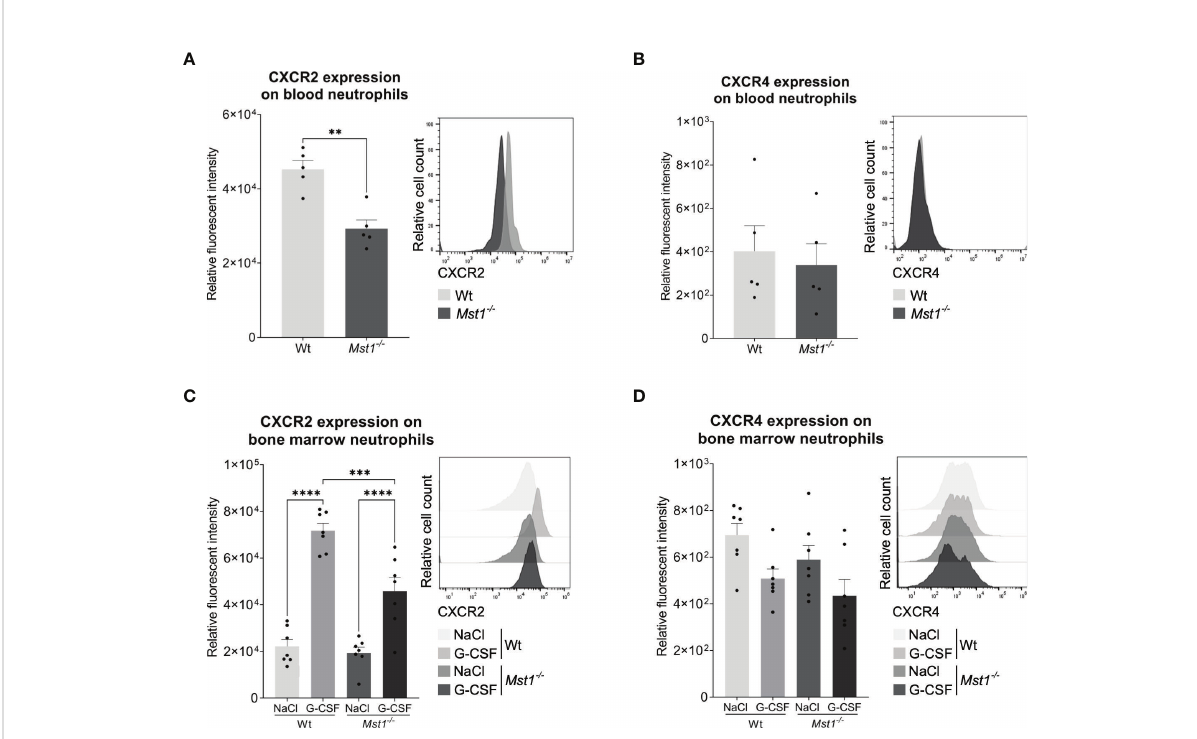
FIGURE 4 STAT3 downstream target CXCR2 is reduced in Mst1 -/- neutrophils after G-CSF stimulation. (A, B) CXCR2 (A) and CXCR4 (B) expression in peripheral blood neutrophils of unstimulated mice; n=5. (C, D) CXCR2 (C) and CXCR4 (D) expression in bone marrow neutrophils 1 day after in vivo G-CSF stimulation; n=7. Unpaired t-test; **p<0.05 (A, B) . Two-way ANOVA (C, D) ; ***p<0.001,